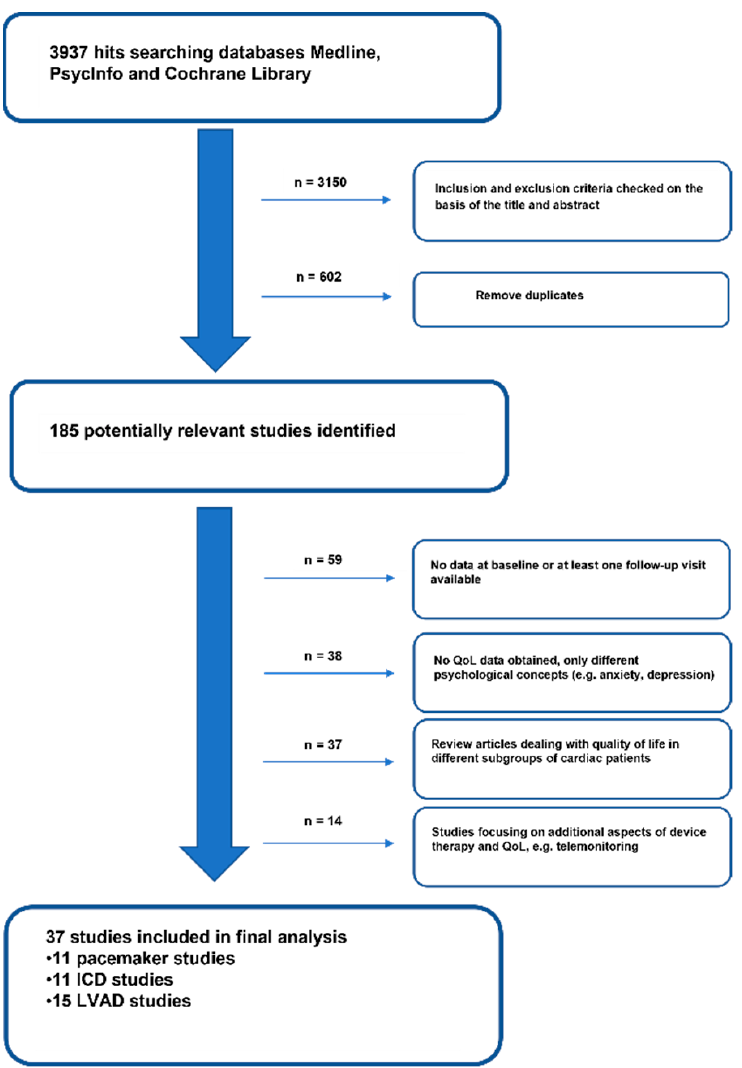
Figure 1. Process of study selection after literature search.